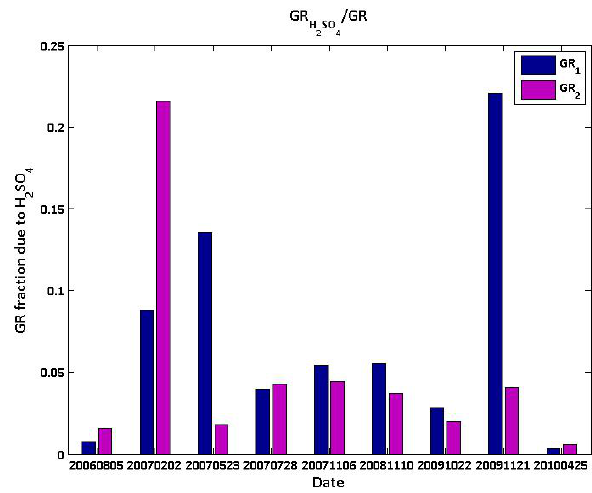
Fig. 4. Growth during the first (GR 1 ) and second (GR 2 ) nucleation and growth event of the day due to H 2 SO 4 condensation only. The GR was estimated for the ion population in size range 3–10nm. The H 2 SO 4 concentration was averaged over 40min centred at about the timing of the growth rate. Shown results are from Botsalano during 5 August 2006–6 November 2007 and from Marikana during 10 November 2008–25 April 2010.